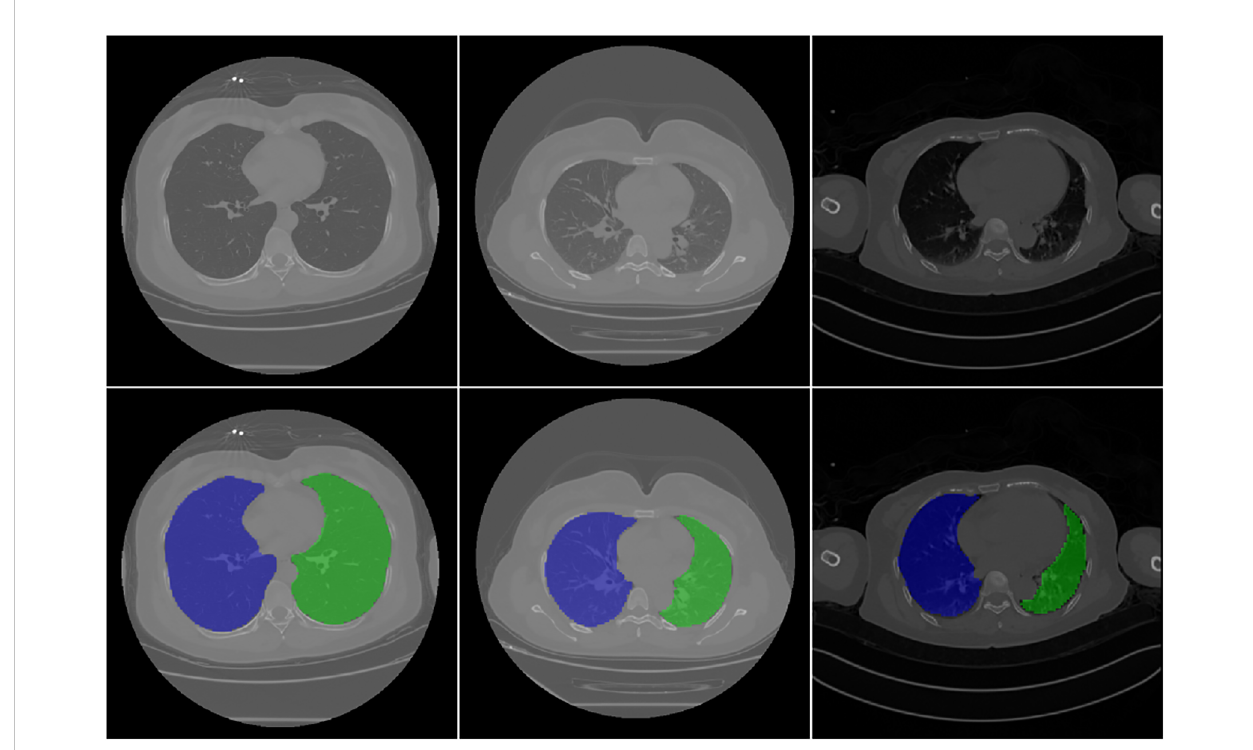
FIGURE 2 CT images and related mask. First raw are original CT image, second raw are the corresponding segmentation results. In the fi gure, the background is shown in black, the right lung is shown in blue, and the left lung is shown in